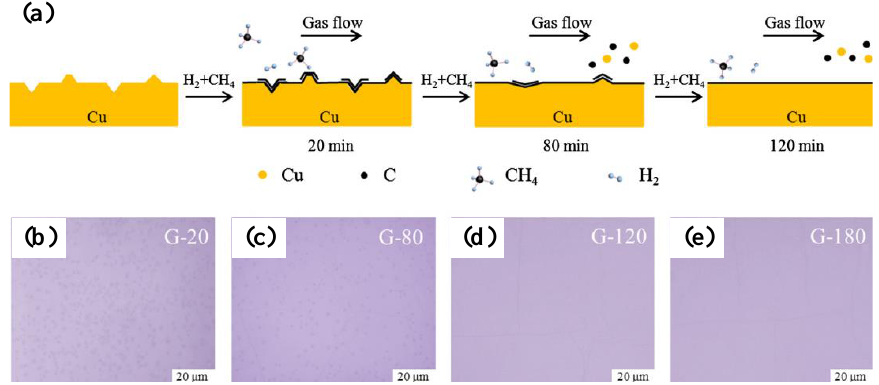
Figure 9. Mechanism of graphene deposition on the Cu in different times and its corresponding optical images. ( a ) Mechanism illustration; ( b ) Optical image after growing 20 min; ( c ) Optical image after growing 80 min; ( d ) Optical image after growing 120 min; ( e ) Optical image after growing 180 min. (Reproduced from [52] with permission; Copyright 2014 Elsevier.)